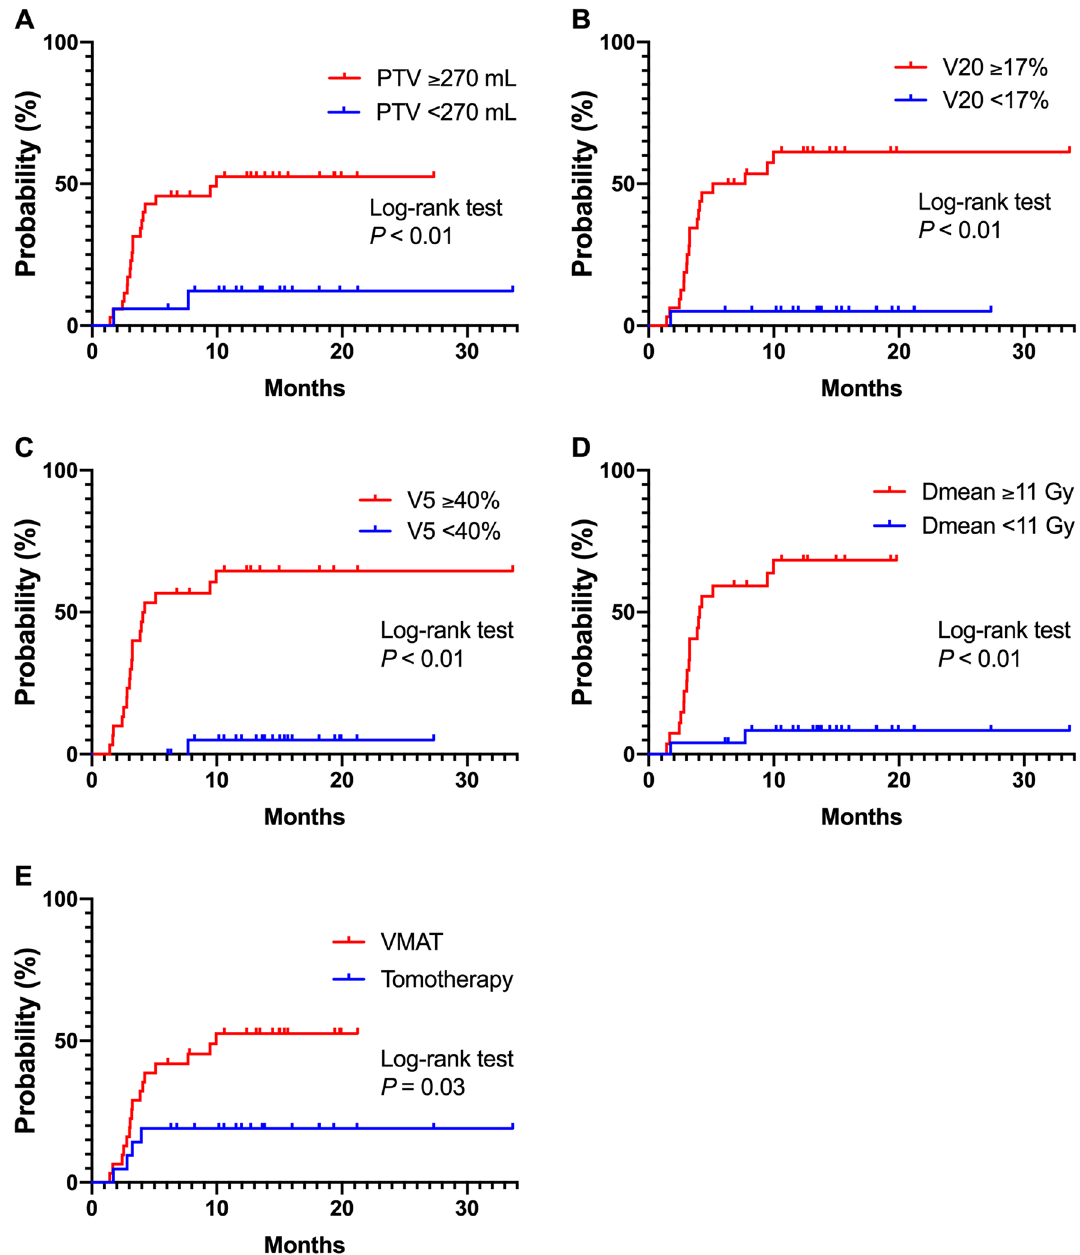
Figure 2. The cumulative incidence of grade ≥ 2 radiation pneumonitis (RP) according to each potential risk factor. The cumulative incidence of grade ≥ 2 RP according to potential risk factor identified as significant in univariate analysis. PTV, planning target volume; V20, lung volume receiving a dose of ≥ 20 Gy; V5, lung volume receiving a dose of ≥ 5 Gy; Dmean, mean dose; VMAT, volumetric modulated arc therapy; HT, helical